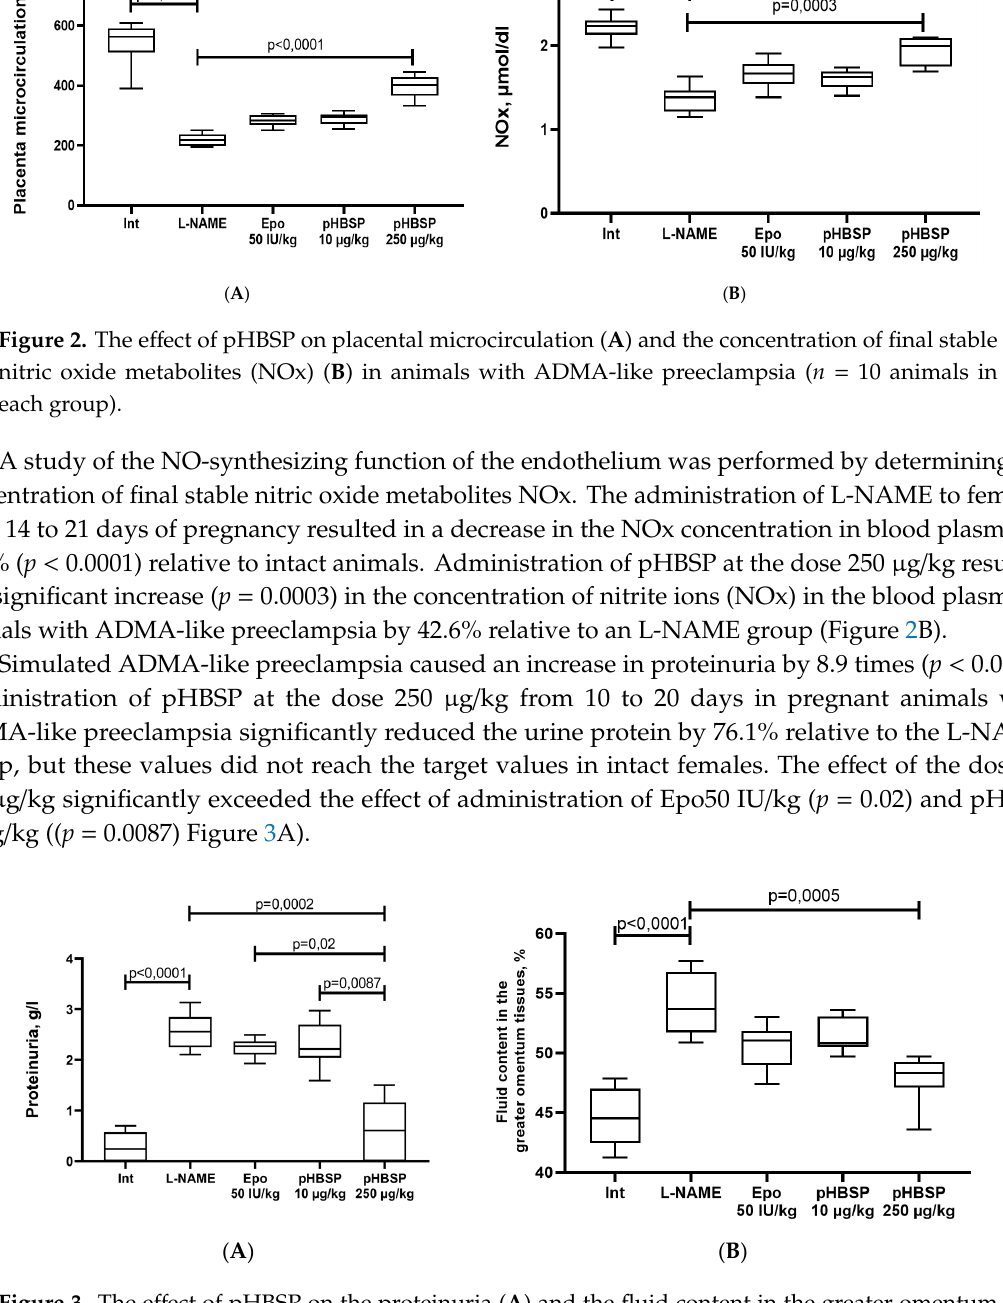
( B ) Figure 4. The level of Bax ( А ) and Bcl-2 ( В ) expression in animals with ADMA-like preeclampsia ( n = 10 animals in each group).